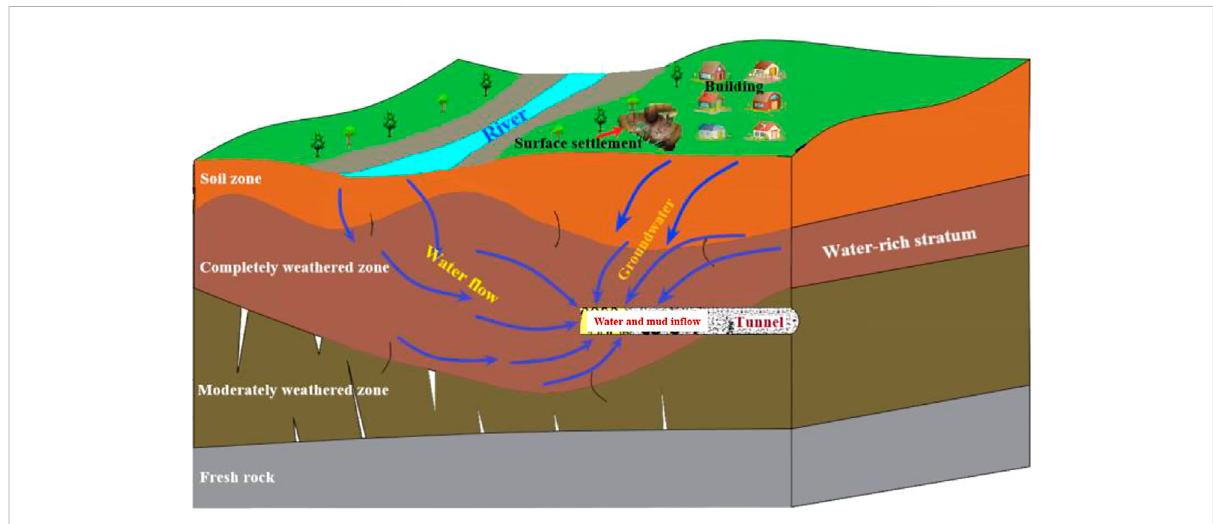
FIGURE 1 Typical unfavorable ground and the related geological disaster induced by tunnel